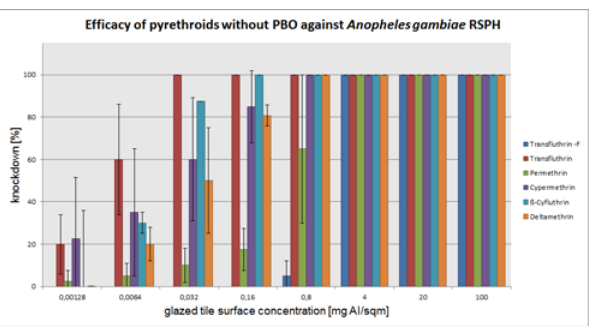
Fig 4. Arithmetic means and standard deviations of the 1 h results of a glazed tile contact bioassay using technical grade pyrethroids without PBO against the kdr- containing Anopheles gambiae RSP-H